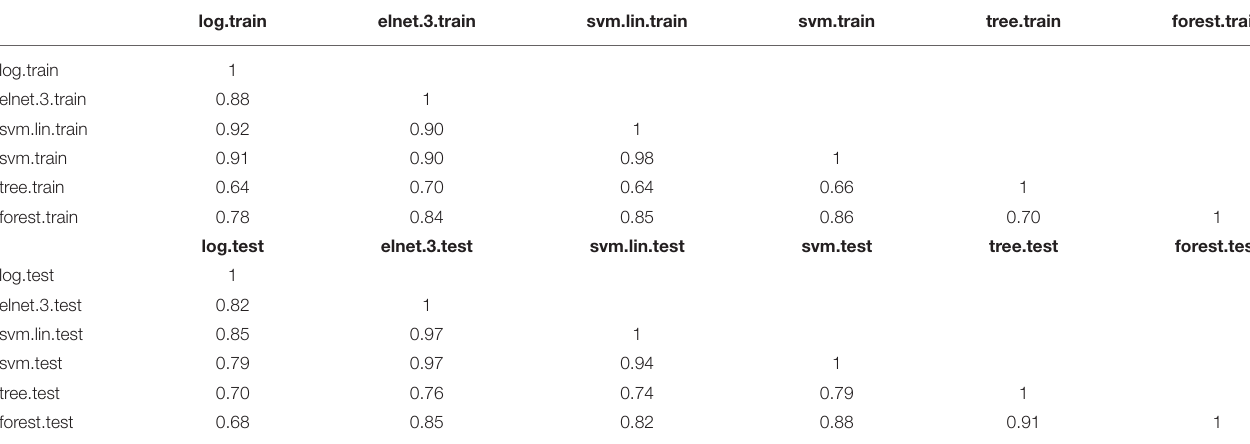
TABLE 7 | Table of inter-rater agreement ( κ ) for the different best predictors on the training set and on the test set.